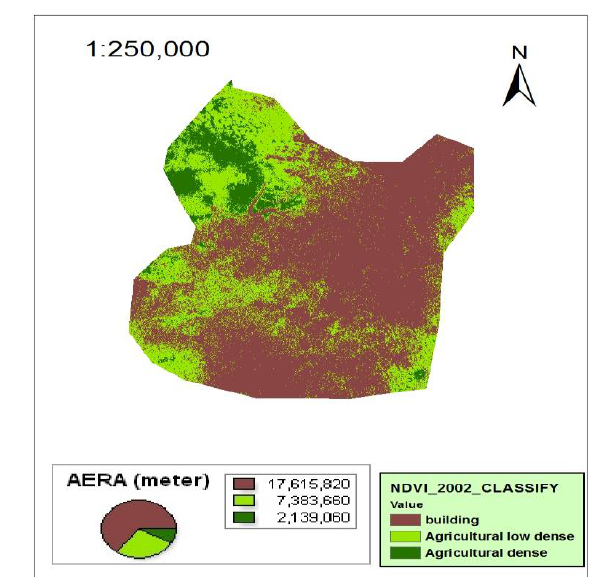
Fig.8: Show NDVI image for study area in date (27/12/2002) with area for each